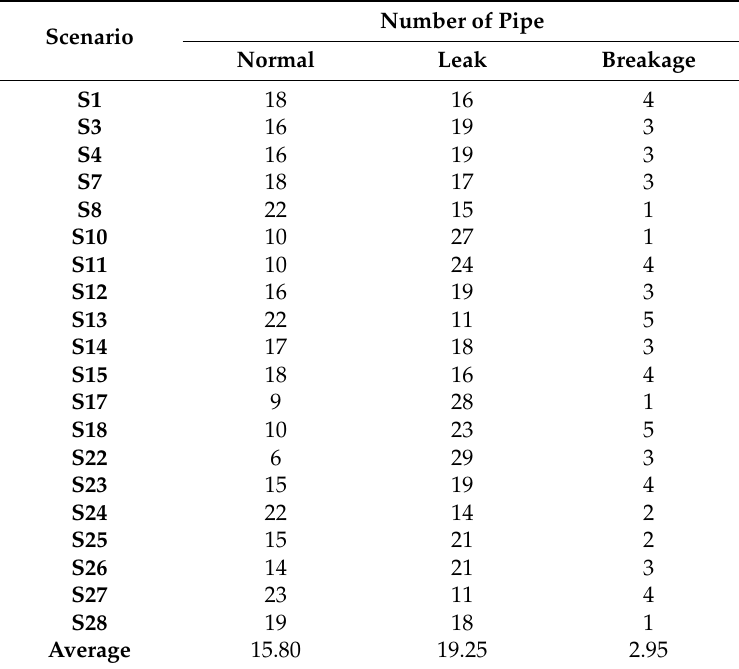
Table 4. Number of pipe according to pipe status (normal, leak,